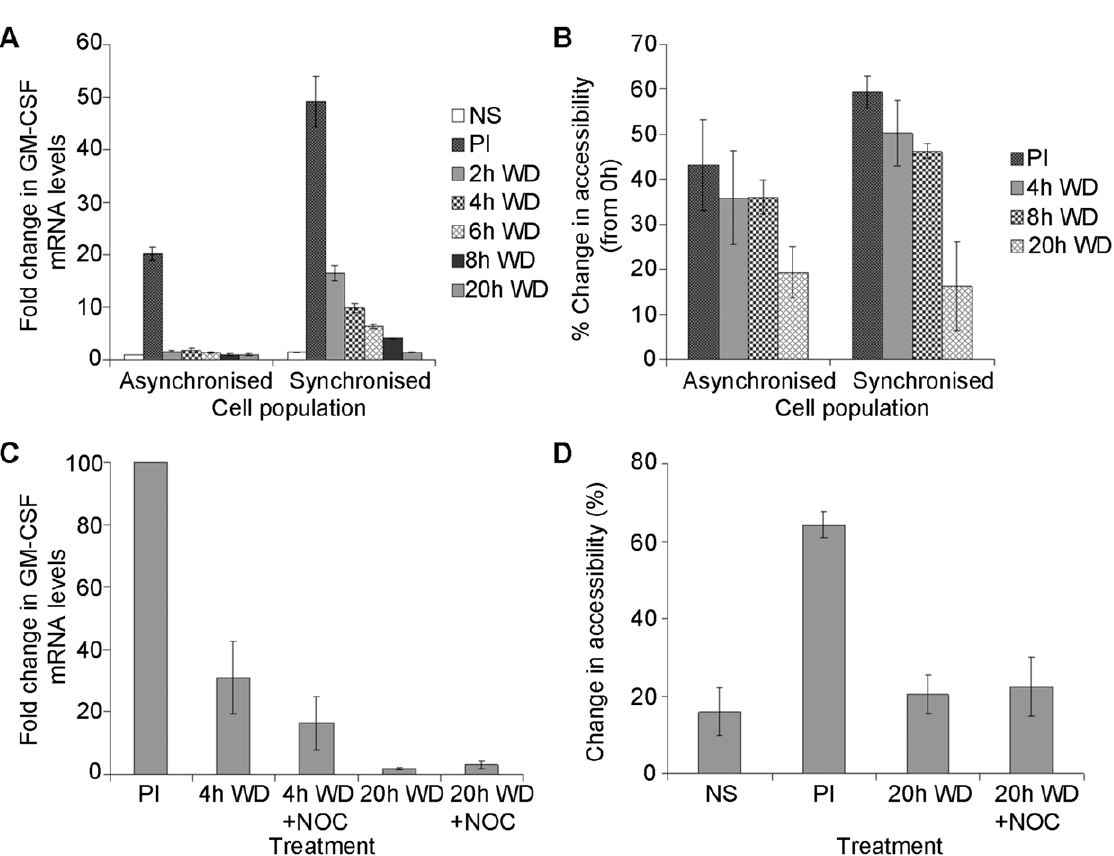
Figure 2. GM-CSF transcriptional down-regulation and promoter chromatin resetting is independent of the cell cycle. (A–B) Asynchronised and synchronised EL-4 T cells were left unstimulated (NS) or stimulated with PI for 4 h (PI) then the stimulus withdrawn (WD) for the indicated times. GM-CSF mRNA levels relative to GAPDH were then determined by RT-qPCR (A) and promoter accessibility to MNase was determined by CHART-PCR (B). The mean and standard error of three independent experiments is shown. (C) GM-CSF mRNA levels relative to GAPDH were determined in EL-4 T cells stimulated with PI for 4 h (PI) and then the stimulus withdrawn (WD) for 4 h or 20 h, with or without nocodazole (NOC), as indicated. GM-CSF mRNA levels are shown relative to the PI sample which was set at 100%. (D) GM-CSF promoter accessibility to MNase was determined in EL-4 T cells treated as indicated. The mean and standard error of five independent experiments is shown (C–D). (Figure 4C) and RelA (Figure 4D) at the IL-2 promoter mirrored chromatin accessibility, with levels of these proteins at the IL-2 promoter increasing following 4 h PI stimulation and then declining following stimulus withdrawal for 20 h or 44 h. RNA polymerase II was also recruited to the promoter following stimulation but had been depleted from the promoter within 20 h of stimulus removal, returning to basal levels by this time (Figure 4E).